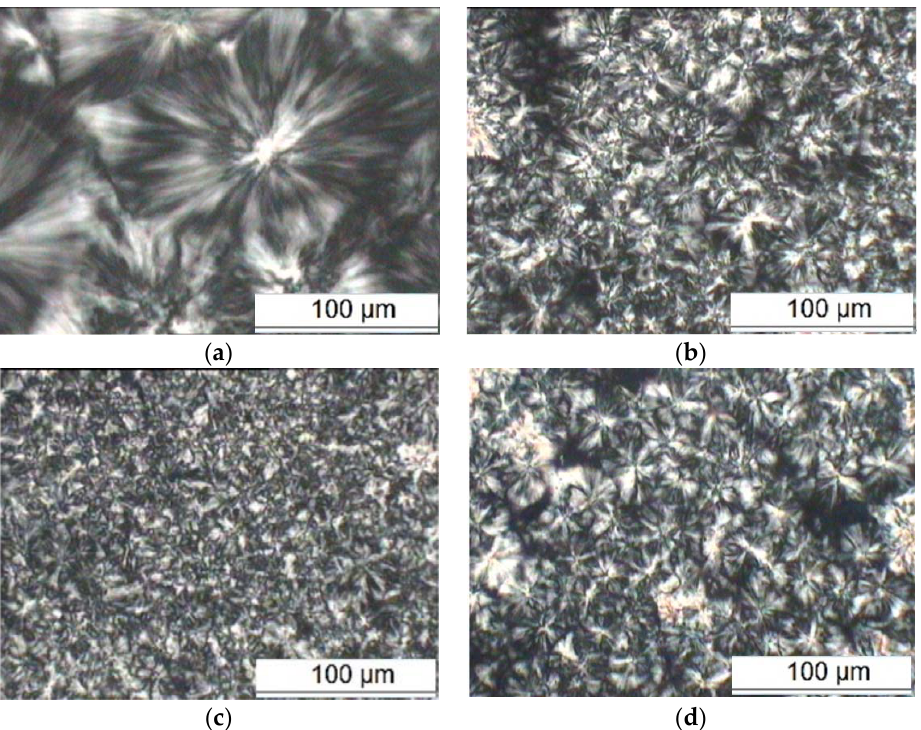
Figure 2. PLM patterns of nano-PP / MgO composites: ( a ) PP; ( b ) 1% nano-MgO / PP; ( c ) 3% nano-MgO / PP; ( d ) 5% nano-MgO / PP.